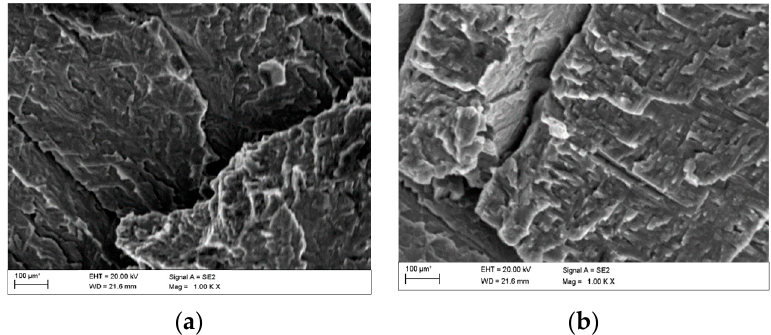
Figure 6. Microscopic images of crack origin, sample from a series subjected to the solution in tap water: ( a ) sample in Figure 4a, ( b ) sample in Figure 4b.